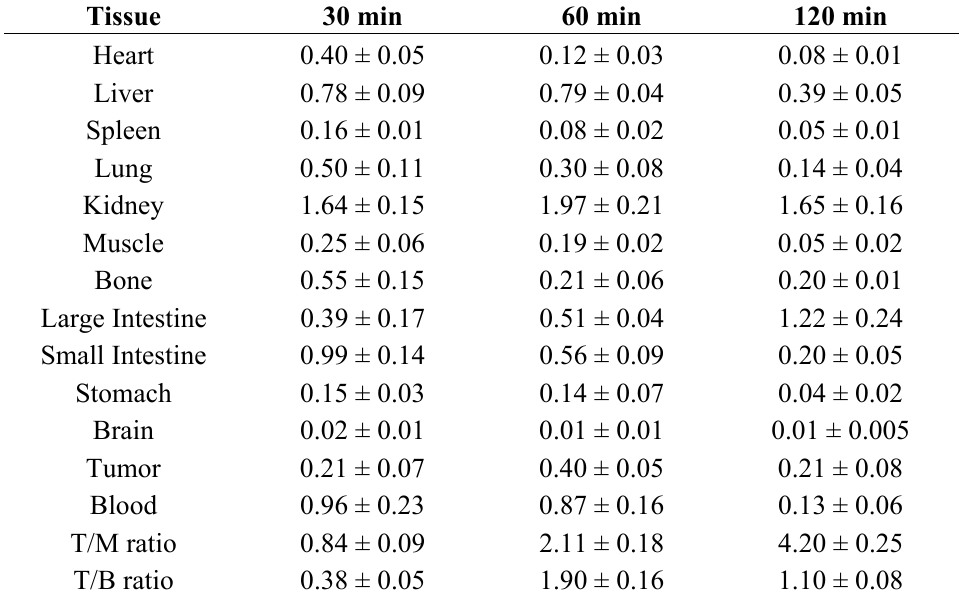
Table 3. Biodistribution of [ 99m TcN]-2 in mice bearing S180 tumor (%ID/g) b .